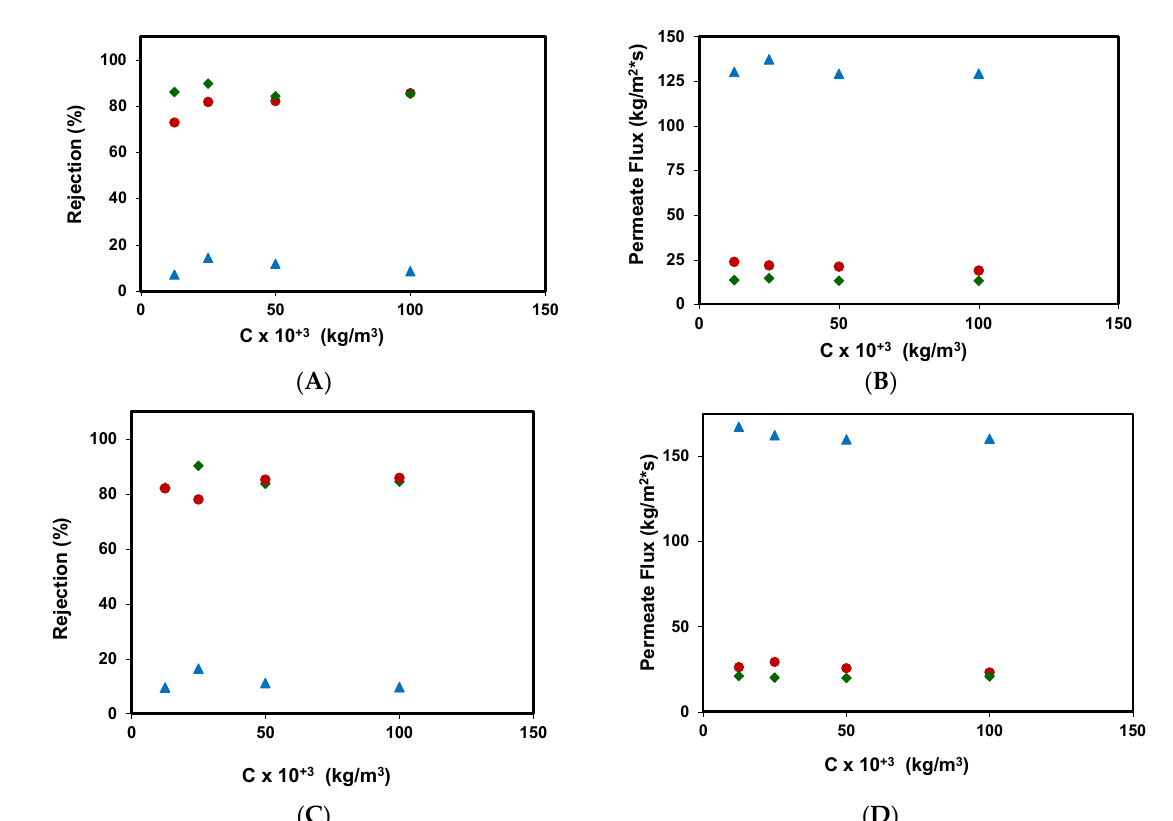
Figure 4. Rejection coefficients and permeate fluxes obtained for the removal of methyl paraben at different feed concen- trations for the different membranes assayed. ( A ) and ( B ) for an applied pressure of 20 bar; ( C ) and ( D ) for an applied pressure of 25 bar: ( )NF99HF, ( ♦ ) RO99, and (●) RO90.